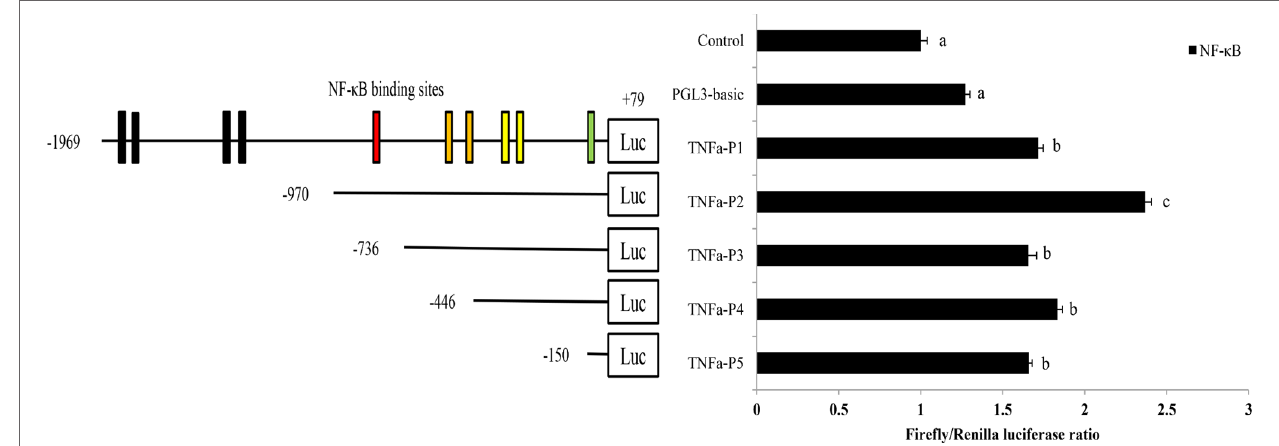
FIGURE 6 | Promoter activity analysis of the ToTNF α gene. The structure and transcriptional activity of the ToTNF α promoter. Five recombinant plasmids, denoted TNF α -P1 (-1,969 to +79), TNF α -P2 (-970 to +79), TNF α -P3 (-736 to +79), TNF α -P4 (-446 to +79) and TNF α -P5 (-150 to +79), were constructed and transfected, along with the transcription factor ToNF- κ B, into HEK 293T cells. Dual-luciferase activity was driven by the ToTNF α promoter upon the transfection of pcDNA3.1- NF- κ B or pcDNA3.1 into HEK 293T cells. Data are presented as the means of three replicates ± SE. Different letters indicate significant differences ( p < 0.05).